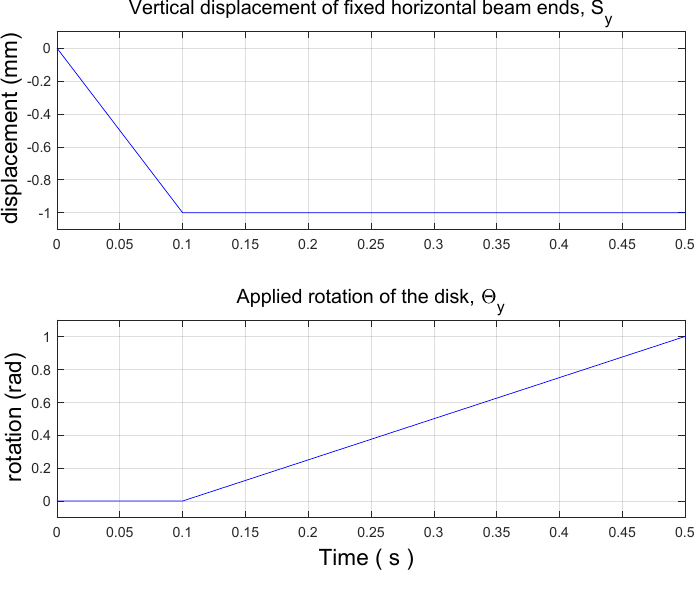
Figure 8. Caliper closing motion.